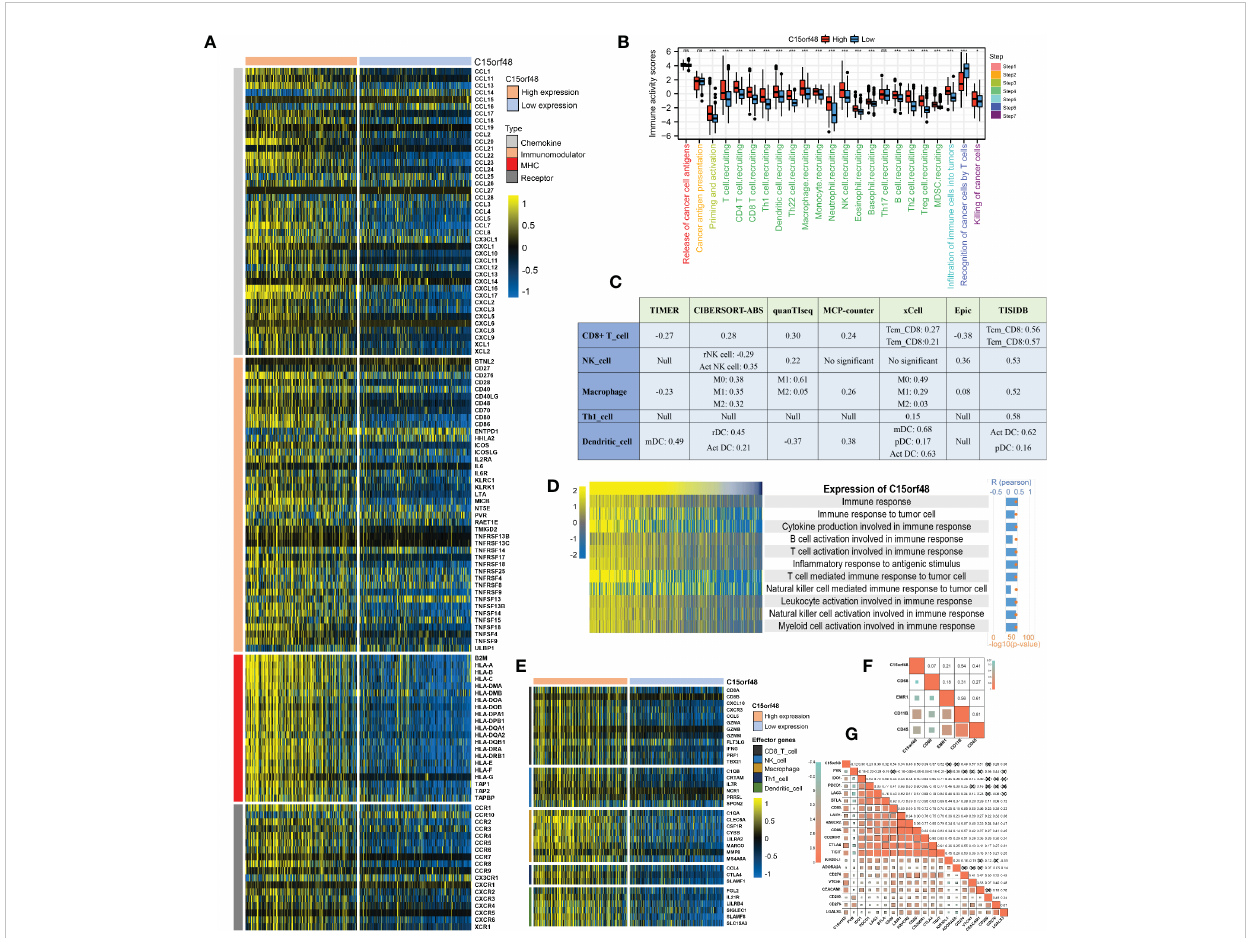
FIGURE 5 (A) Correlation between C15orf48 and 122 immune modulators (chemokines, receptors, MHC and immunostimulants) in THCA; (B) Differences in the various steps of the cancer immunity cycle between high- and low-C15orf48 groups; (C) Seven algorithms evaluate the correlation between C15orf48 and immune cell in fi ltration in THCA; (D) GSVA assesses the relevance of C15orf48 to some immune pathways; (E) Differences in the effector genes of the tumor-associated immune cells between high- and low-C15orf48 groups; (F) Correlation between C15orf48 and macrophage marker genes in THCA; (G) Correlation between immune checkpoints and C15orf48 in THCA. *p < 0.05; **p < 0.01; ***p < 0.001; NS, No Signi fi